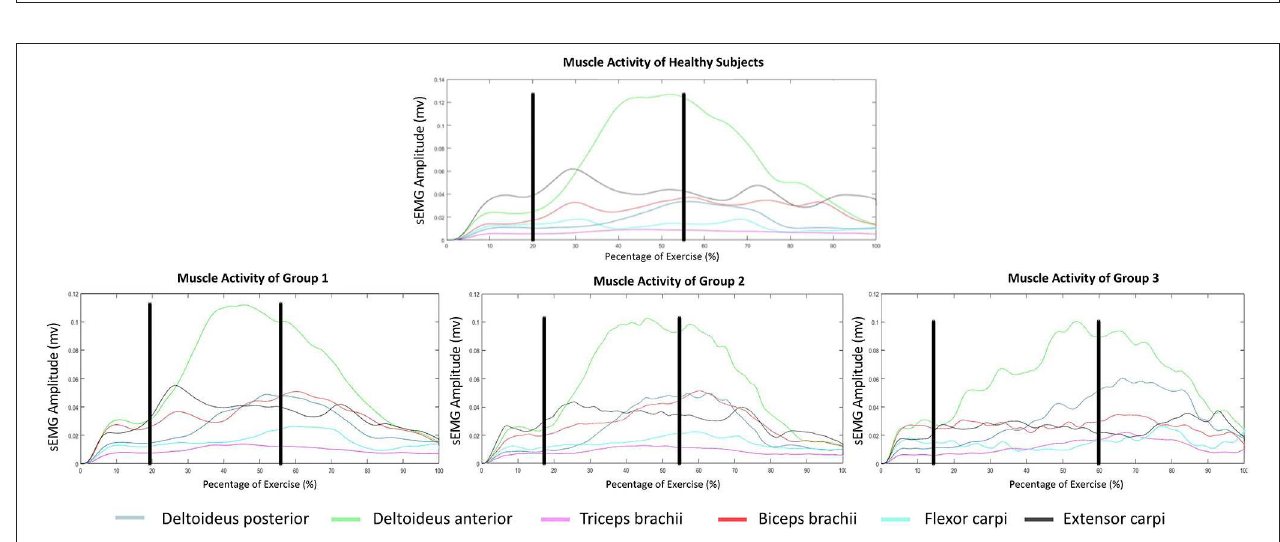
FIGURE 2 | Median scores of clinical variables comparing the three subgroups. *Significant p -value.